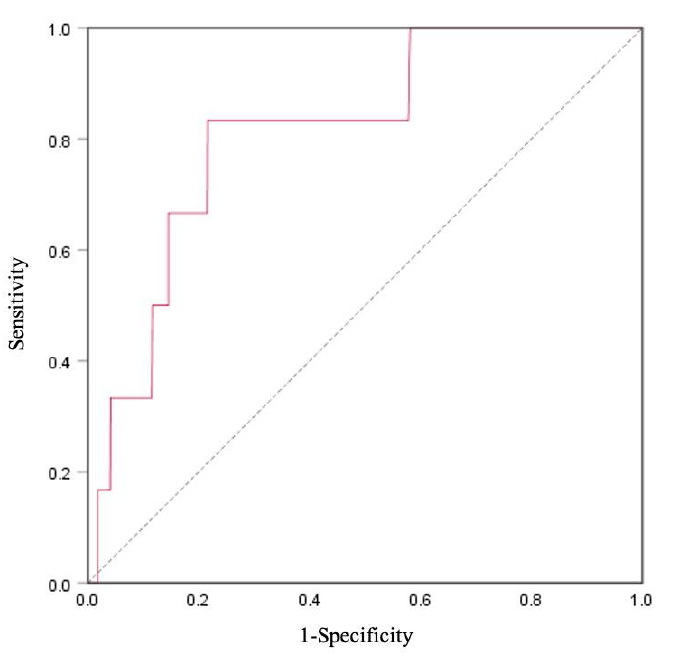
Figure 2. Receiver operating characteristic (ROC) curve of Framingham risk score (FRS) and XOR activity for cardiovascular disease (CVD) prediction in total participants ( n = 1631). The area under the curve (AUC) of CVD was 0.81 (95% CI = 0.66–0.97), p = 0.008.